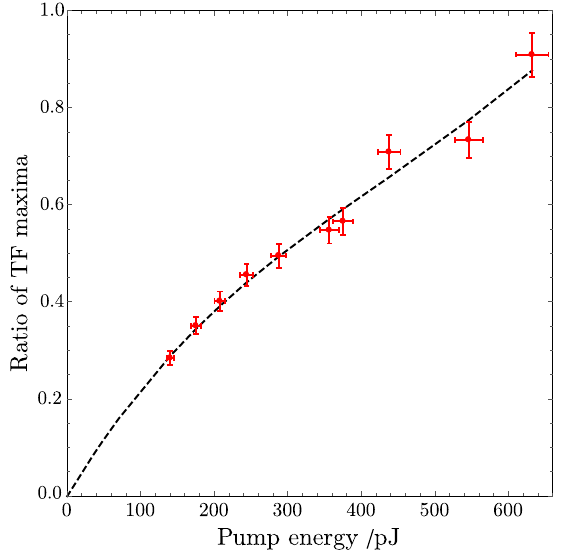
FIG. 6. Ratio between the self- and cross-mode transfer functions ( κ ) for different pump pulse energies.